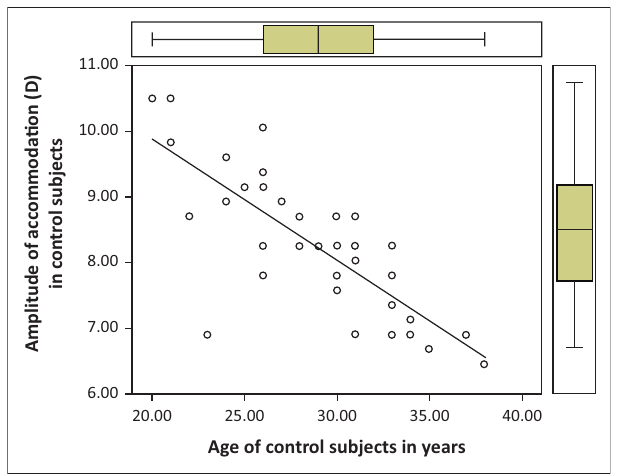
FIGURE 3: Correlation between the subjective amplitude of accommodation and age of the control